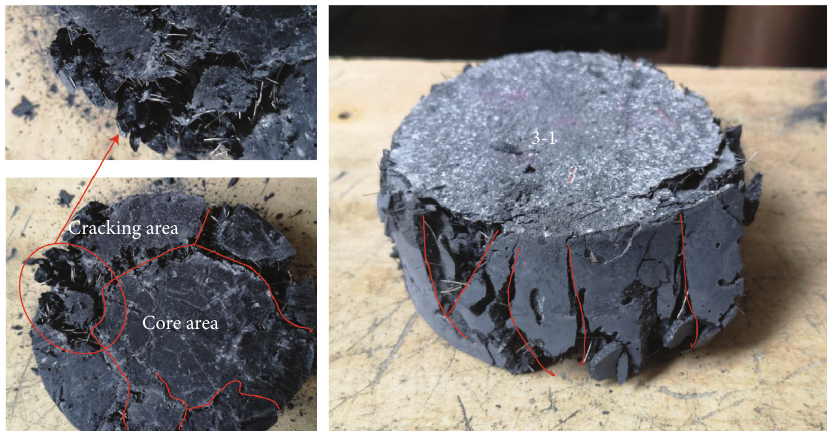
Figure 13: Failure modes of the third set of turntable specimens.